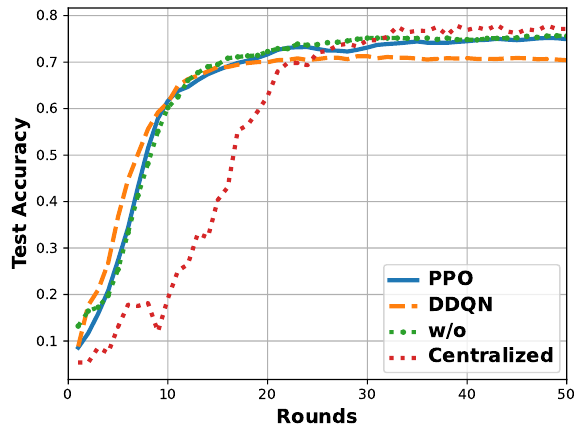
Figure 7. Comparison of test accuracy per round among different ConvLSTM model training schemes: FL with PPO-based FCS, FL with DDQN-based FCS, FL without FCS (w/o), and